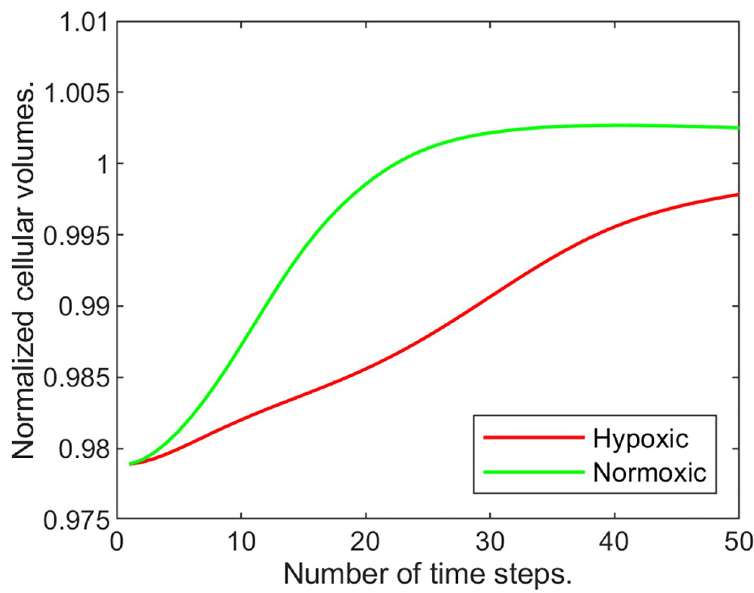
Fig 10. Normalized cellular volumes of live cells changing with time. Green line: results of the simulation under normoxic conditions. Red line: results of the simulation under hypoxic conditions.